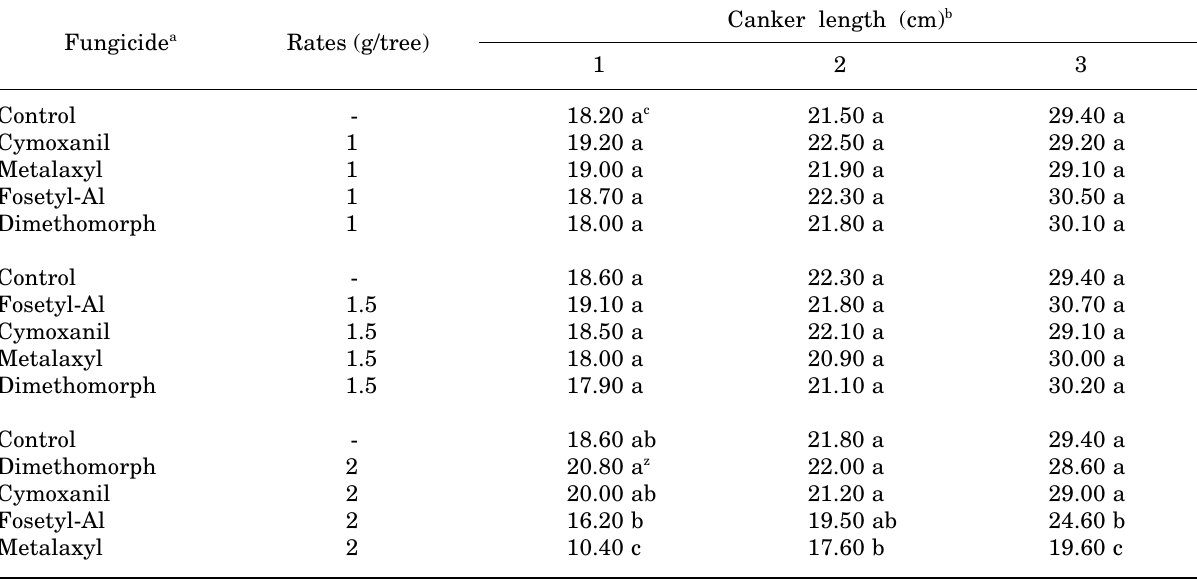
Table 3. Canker length (cm) of 2-year-old KID I peach seedlings after inoculation with Phytophthora cactorum . Inoculated plants were soil-drenched with metalaxyl, fosetyl-Al, dimethomorph, and cymoxanil one, two and three weeks after the